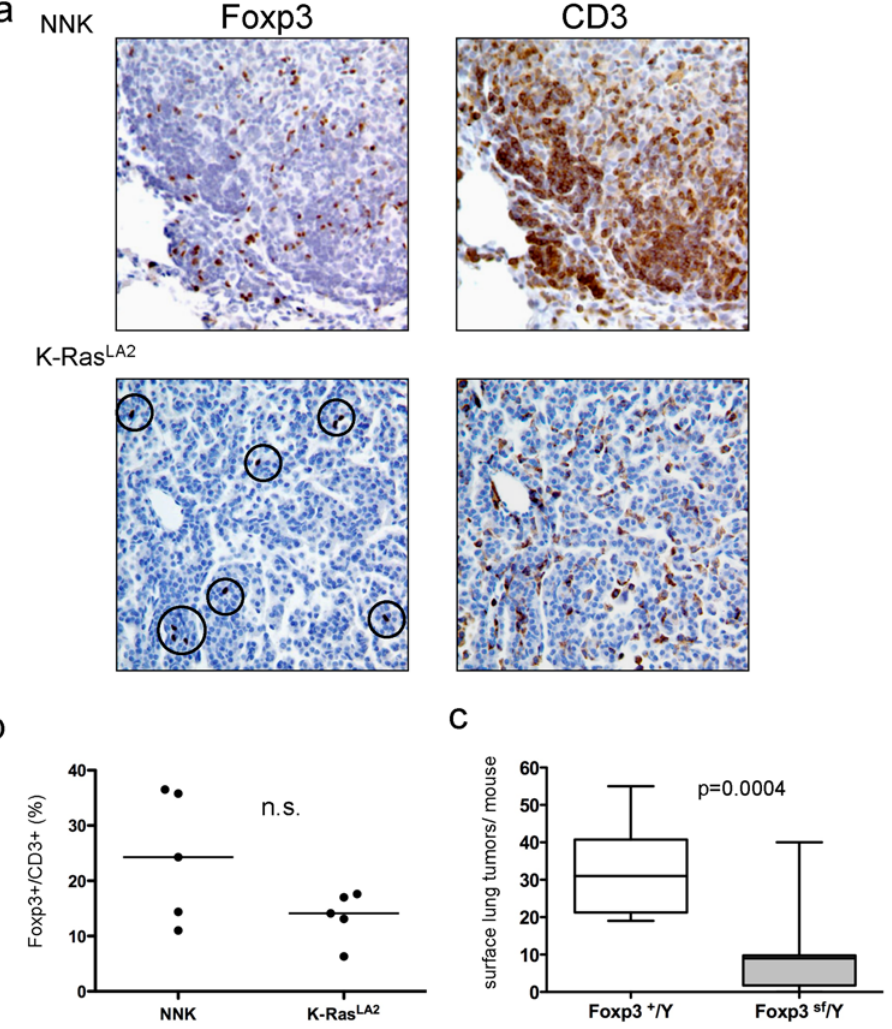
Figure 4. Genetically engineered mice that lack Foxp3 + cells develop fewer K-Ras driven lung tumors. ( a ) Representative IHC of tumor- associated Foxp3 + and CD3 + cells in tobacco-carcinogen (NNK) and K-ras LA2 transgenic mouse models of lung tumorigenesis. ( b ) Quantification of IHC analysis in (a) for tumor-associated percent of Foxp3 + /CD3 + cells. Each point represents a mouse and the line represents the median; n.s., not significant. ( c ) Tumor multiplicity in K-RAS LA2/wt /Foxp3 2 /Y or K-RAS LA2/wt /Foxp3 + /Y offspring. Boxes indicate interquartile range, lines indicate median, and whiskers indicate minimal and maximal values.